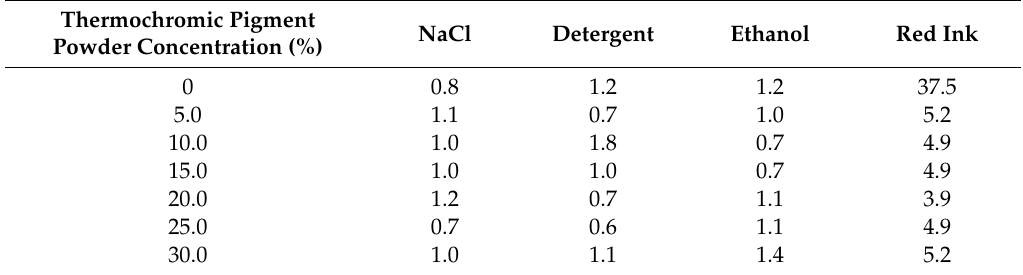
Table 8. Influence of thermochromic pigment powder on the color di ff erence of the waterborne primer